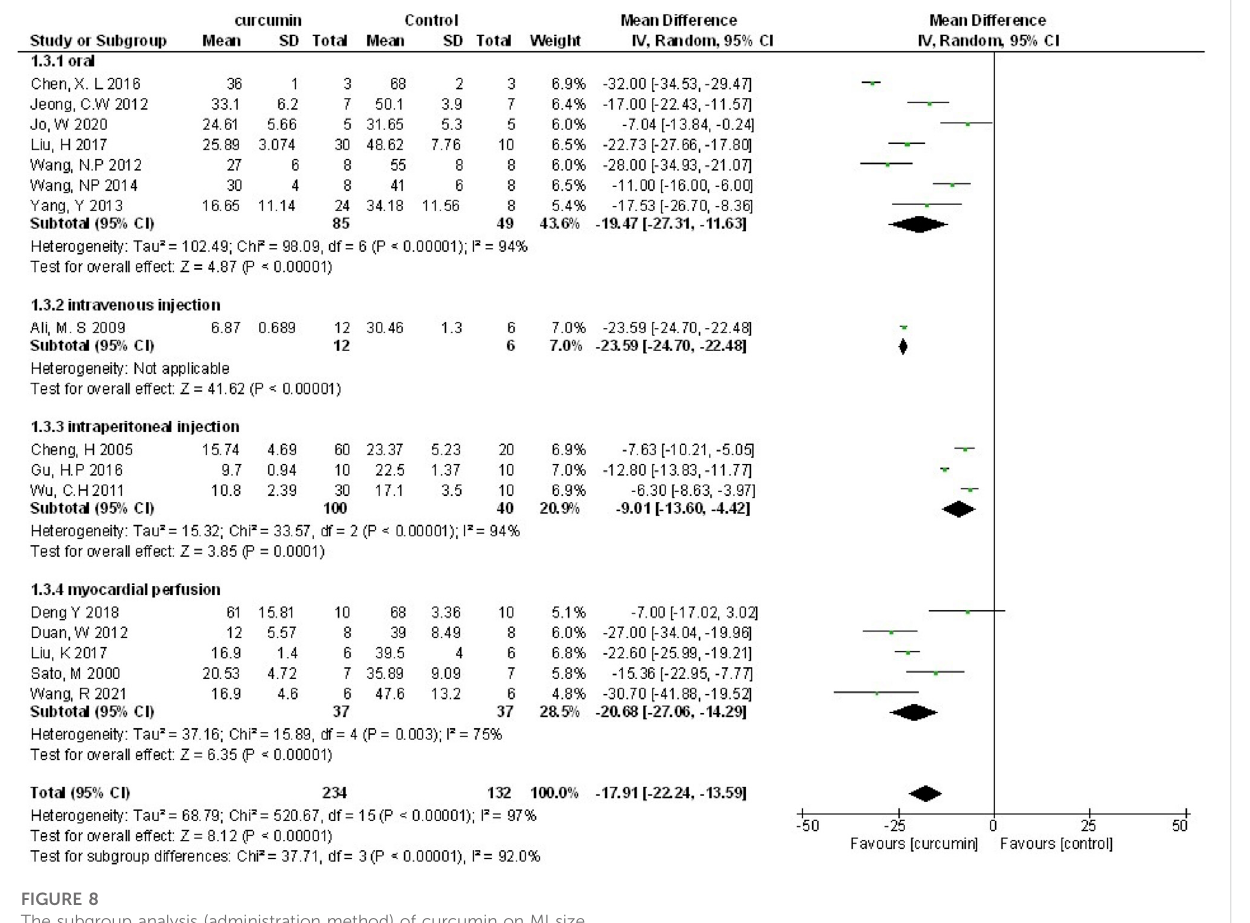
The subgroup analysis (administration method) of curcumin on MI